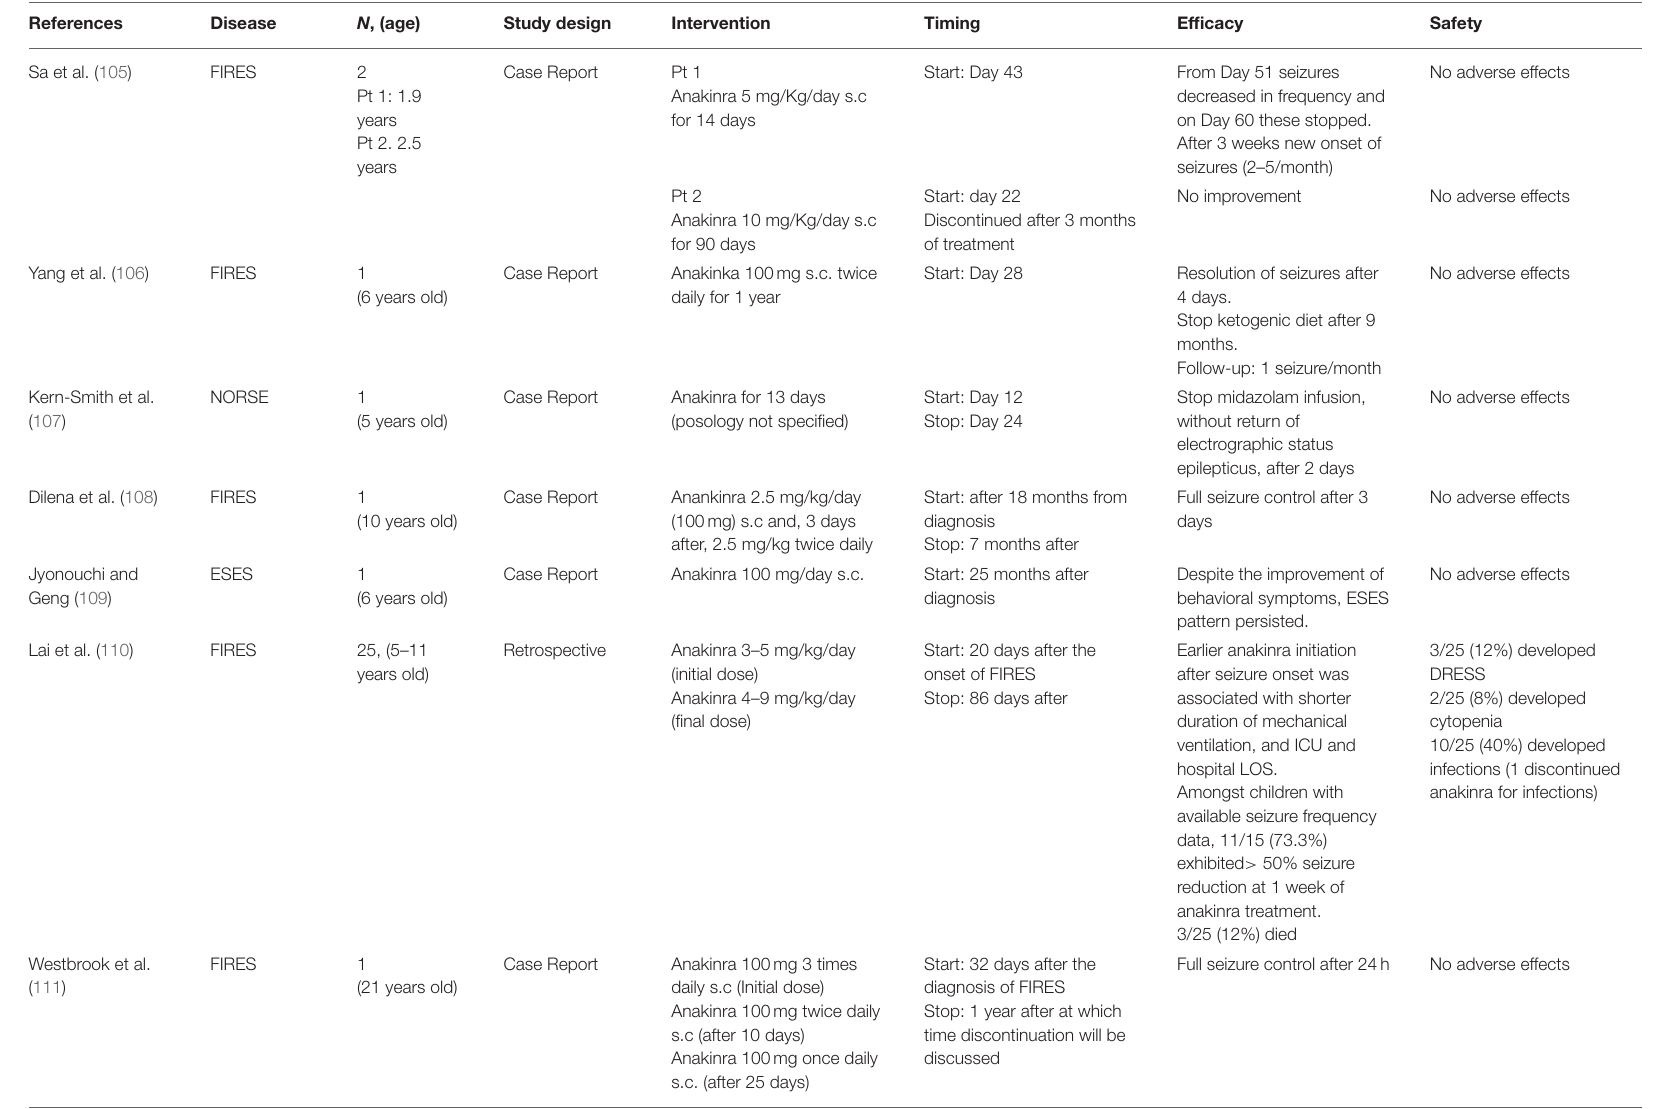
TABLE 2 | Systematic review of anti-IL-1 agents in